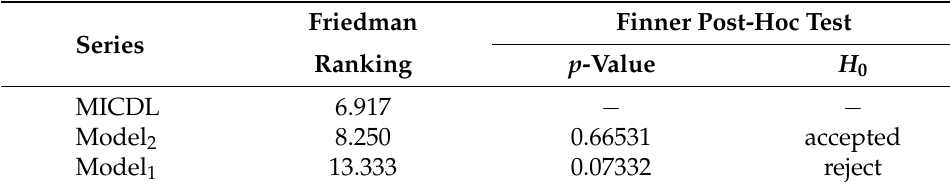
Table 10. FAR test and Finner post hoc test based on the area under curve (AUC) metric.